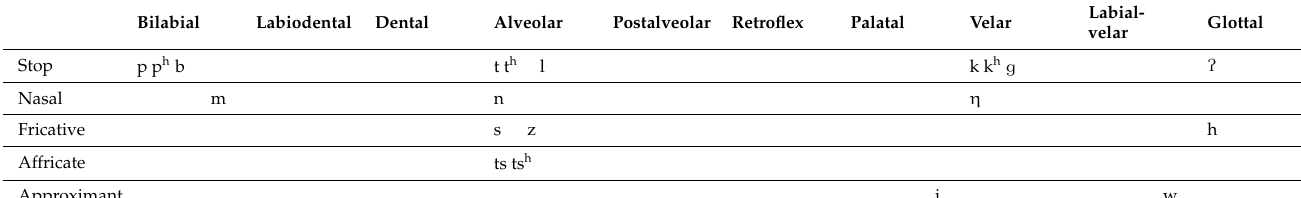
Table 1. The consonant inventory of Min in IPA (Following [27]).